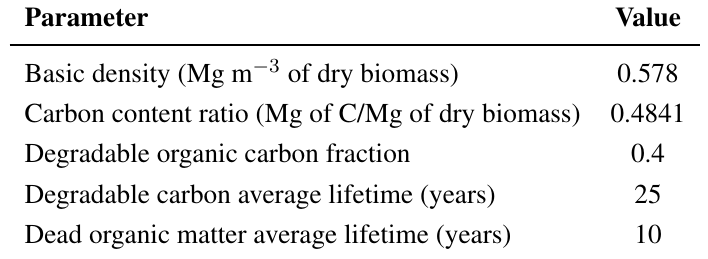
Table 2. Additional parameters that were specified in LERFoB-CAT for the simulations of the carbon